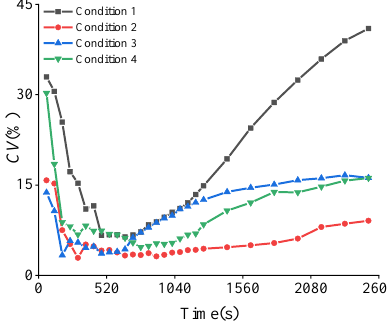
Figure 11. CV of the four conditions.